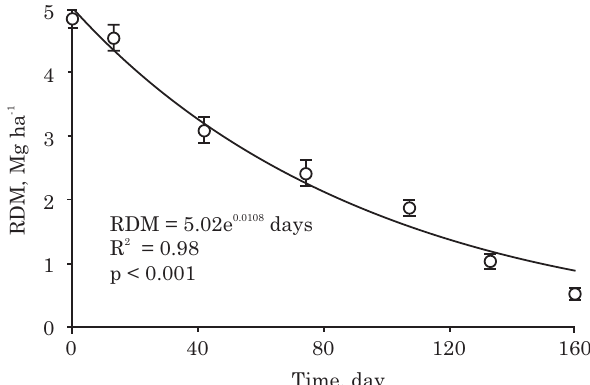
Figure 3. Remaining dry matter (RDM) from black oat residues over time (days) after desiccation. Vertical bars indicate the standard error of the